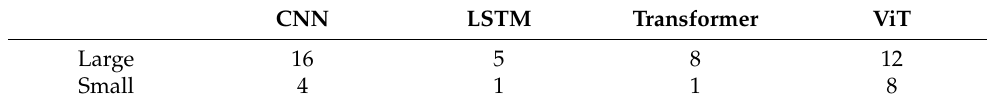
Figure 10. Network architectures for the ViT ( left ) and Transformer ( right ). Table 1. Depths of the backbone for each type of network shown in Figures 9 and 10.